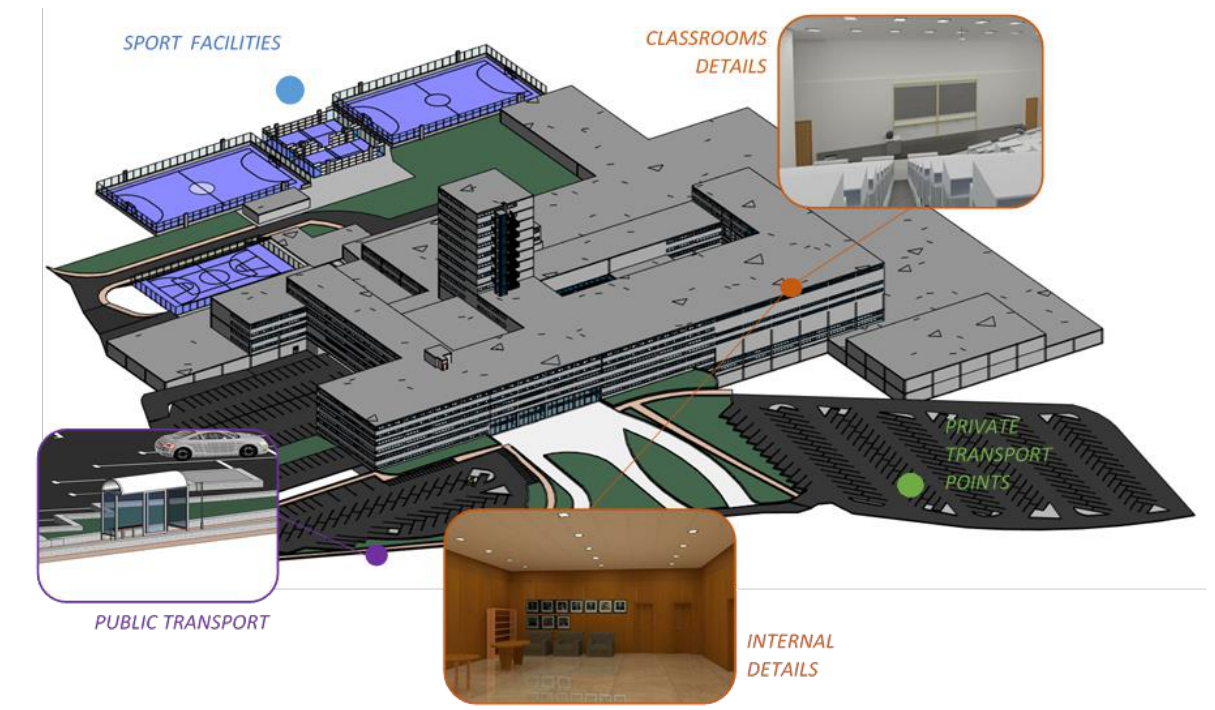
Figure 8. BIM model of the ETSICCP.